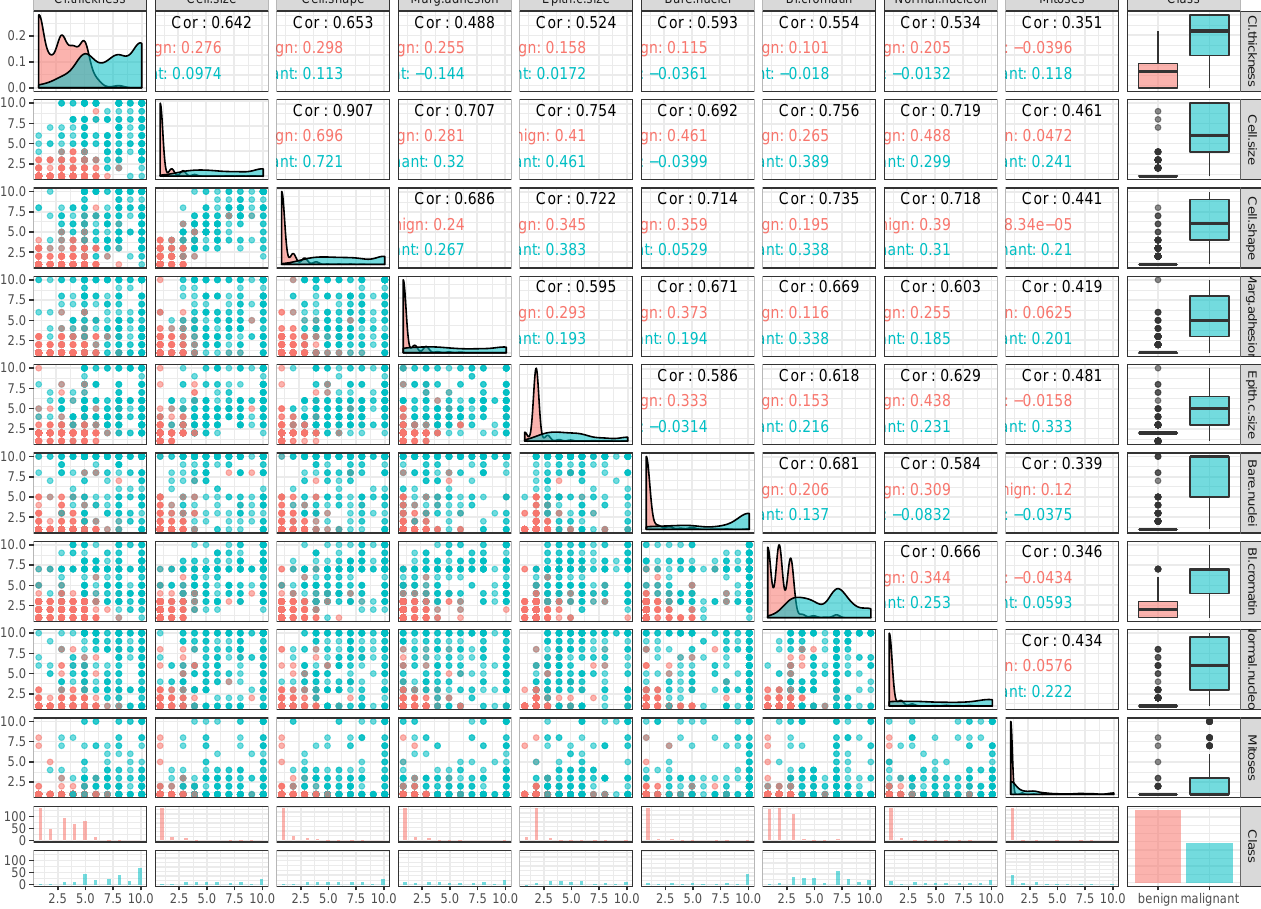
Figure 4. Scatter plot and correlation between variables by response for the breast cancer data. Figure 5 shows the plot of the correlation, group distribution, and scatter plot between the variables and response in the heart disease data. We conclude with a background on the prostate cancer dataset. The studied prostate cancer data came from a study by Stamey [4]. The data consist of log cancer volume (lcavol), log prostate weight (lweight), age, log of the amount of benign prostatic hyperplasia ( lbph ) , seminal vesicle invasion (svi), log of capsular penetration ( lcp ) , Gleason score (gleason), and percent of Gleason scores 4 or 5 ( pgg45 ) . The response we are predicting is the Gleason score (gleason). the variables and response in the prostate cancer